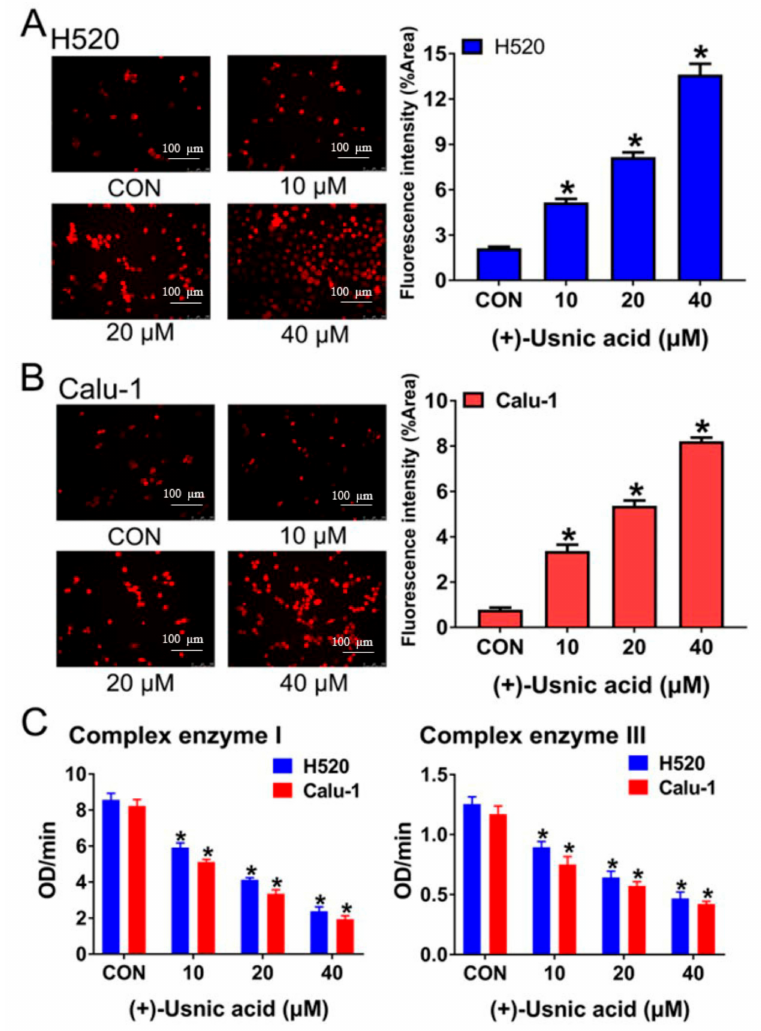
Figure 3. ( + )-Usnic acid (UA) damages MRC and increases mitochondrial ROS. ( A , B ) Mito-SOX (a highly selective indicator of superoxide in live cell mitochondria) fluorescence intensity in H520 and Calu-1 cells treated with the indicated concentrations of UA detected by fluorescence microscope technique analysis. Significantly di ff erent from control group, * p < 0.05, n = 3. ( C ) Measurement of the mitochondrial complex I and III activity exposure to UA at the indicated concentrations after 12